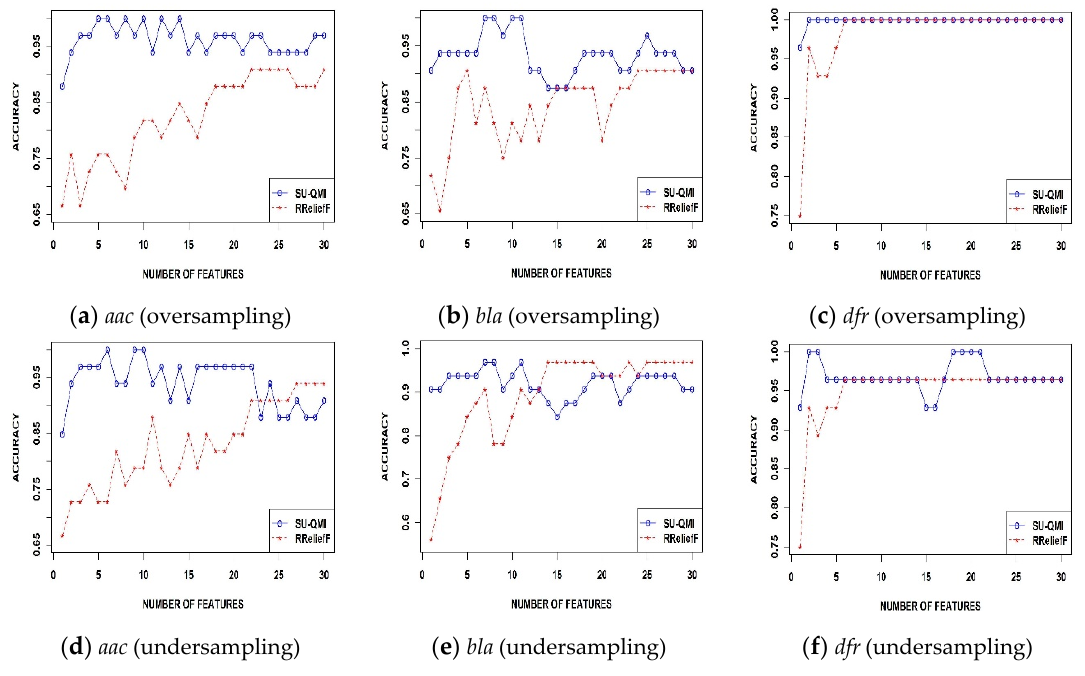
Figure 1. Accuracy comparison between SU-QMI and